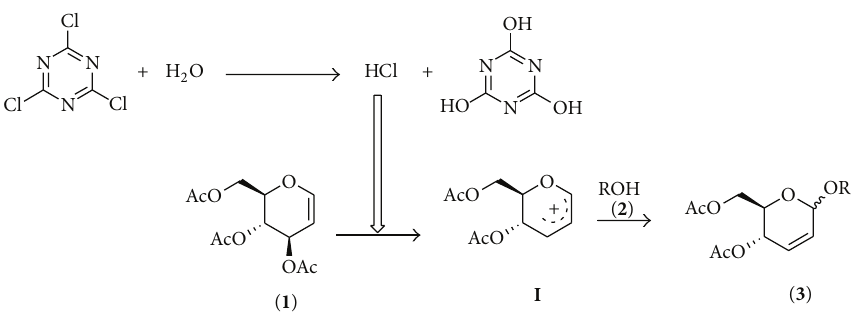
Scheme 2: Plausible mechanism for the formation of 2,3-unsaturated O